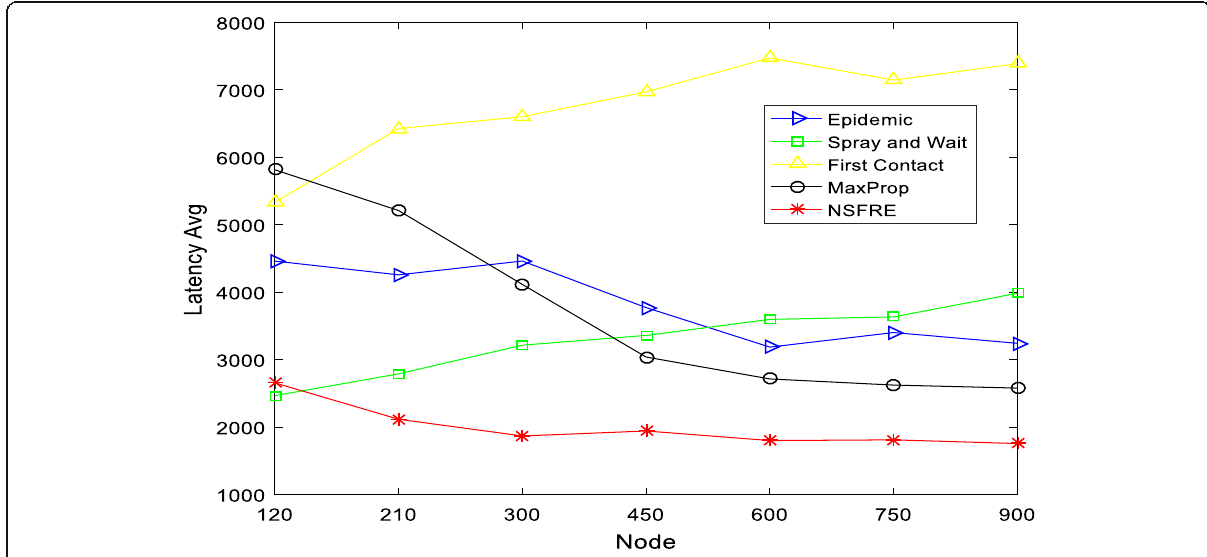
Fig. 9 The relationship between the average transmission delay and the number of